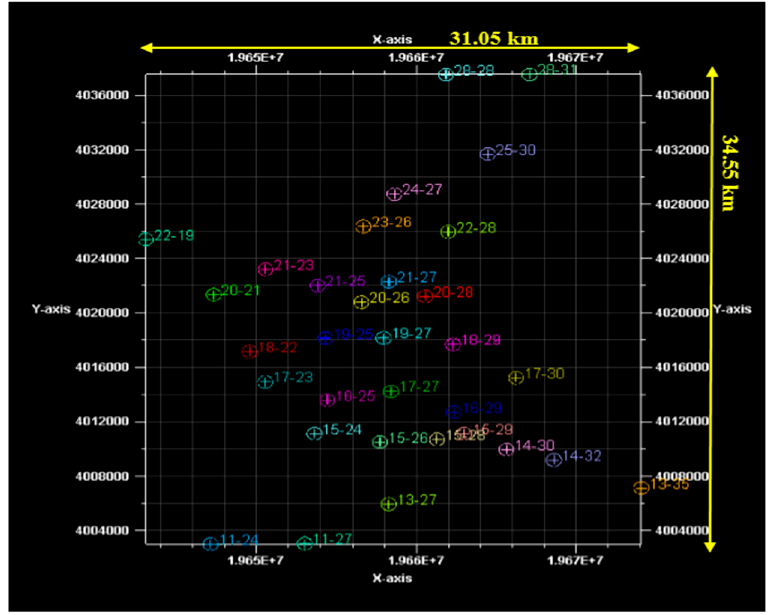
Figure 1. The drilled wells in the coalbed methane (CBM) gas field from where the seismic data and core samples were